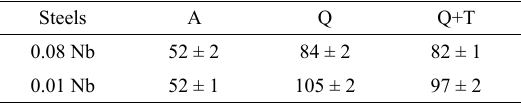
Table 2. Rockwell B hardness values after annealed at 930 ºC (A), quenching at 900 ºC (Q) and quenching at 900 ºC plus tempering at 600 ºC (Q+T).